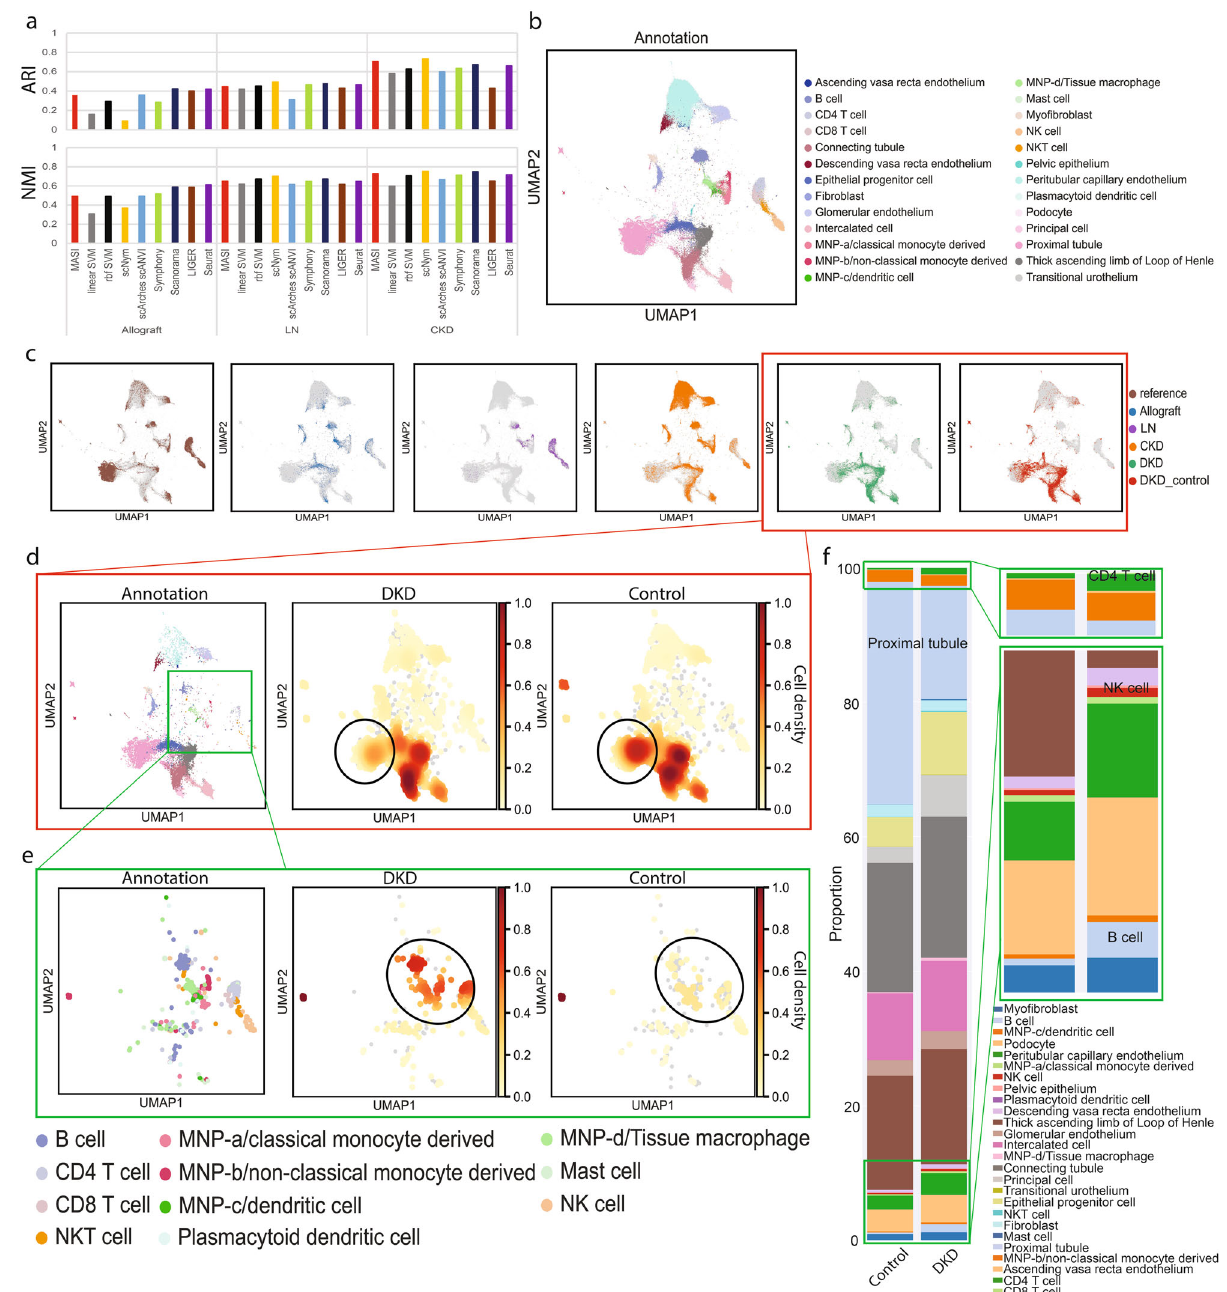
Fig. 4 Transferring human kidney atlas for integration of single-cell human kidney across conditions. a Comparison of label transferring for MASI, supervised, and semi-supervised methods. ARI and NMI are calculated by comparing method-reported annotation with author-reported annotation in a study-wise manner. b Visualization of the integrative annotation by MASI. Cells are colored according to MASI-reported cell-type annotation. c Visualization of integration by MASI. Cells are colored according to the study id. d and e Population densities in DKD and control samples. Cell type annotation is shown on the left panel. Cell-type population densities of DKD and control samples are presented separately to highlight differences in cell- type populations. f Quantitative measurement of cellular compositions. CD4 + T cell, NK cell, and B cell are zoomed in to show the difference between control and DKD